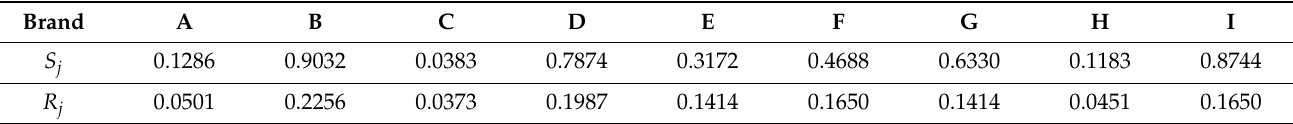
Table 3. The group utility and the individual regret.